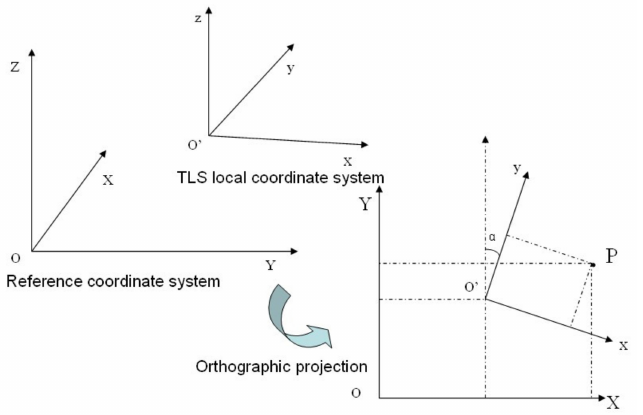
Figure 2. Principle of